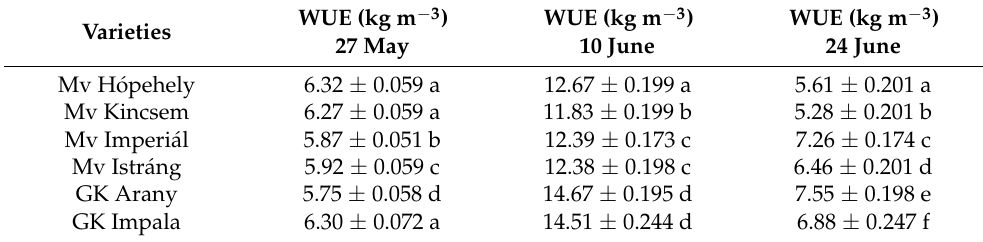
Table 3. Water use efficiency (WUE) of oat varieties. Mean of the treatments and standard errors (2021, Debrecen).